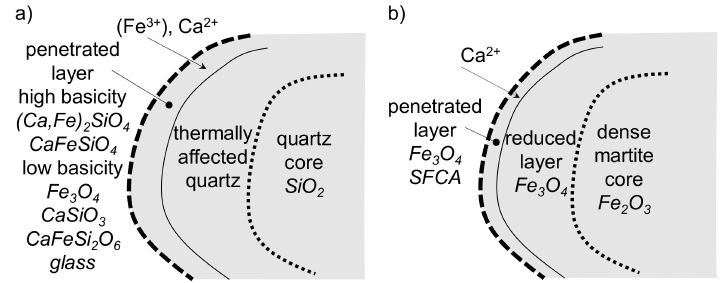
Figure 19. Ore assimilation scheme in the SM-S